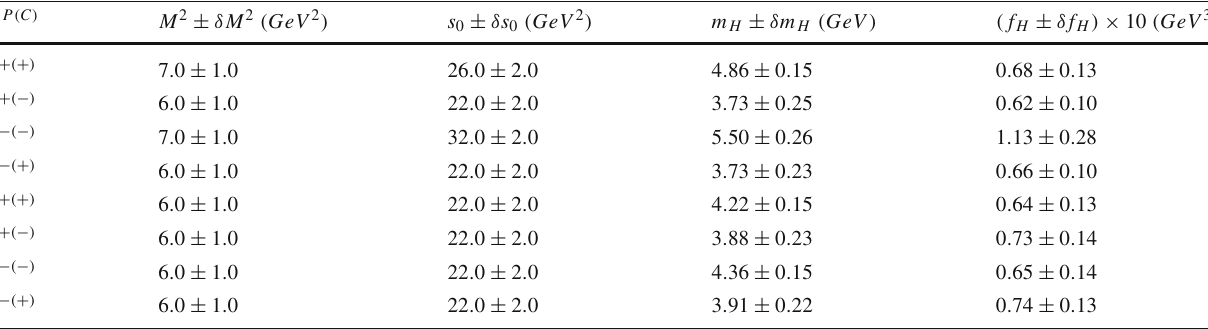
Fig. 2 The current coupling of the charm-nonstrange hybrid meson with the quantum numbers J P ( C ) = 1 − ( − ) as a function of the Borel parameter M 2 at fixed values of s 0 (left panel), and as a function of the continuum threshold s 0 at fixed values of M 2 (right panel) Table 5 Values of the mass and current coupling for different quantum numbers of the ground state charm-nonstrange hybrid mesons